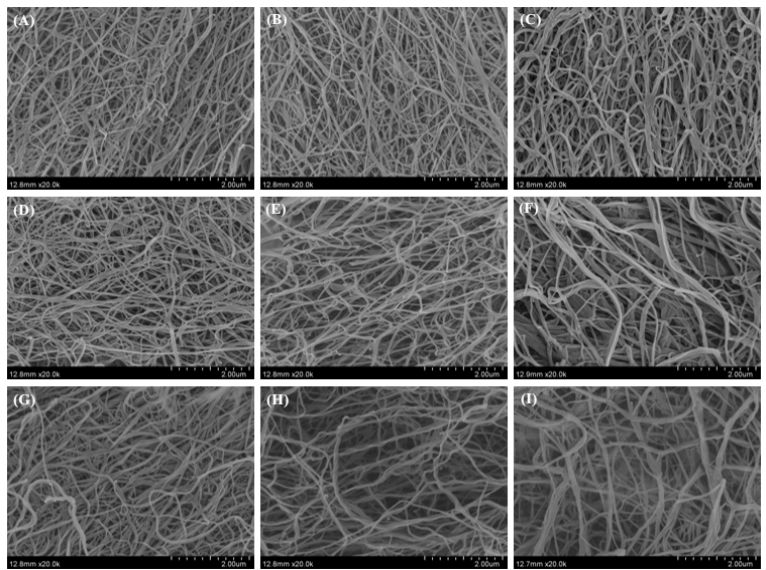
Figure 8. Morphological observation of C. idella skin collagen (SC) fibrils under different salinity and pH: ( A – C ) collagen with NaCl concentration of 0, 140, and 280 mM and pH 6; ( D – F ) collagen with NaCl concentration of 0, 140, and 280 mM and pH 7; ( G – I ) collagen with NaCl concentration of 0, 140, and 280 mM and pH 8. Scale bars, 2 μm. Table 2. Average diameter of C. idella skin collagen (SC) and swim bladder collagen (SBC) fibrils under different salinity and pH conditions ( n =